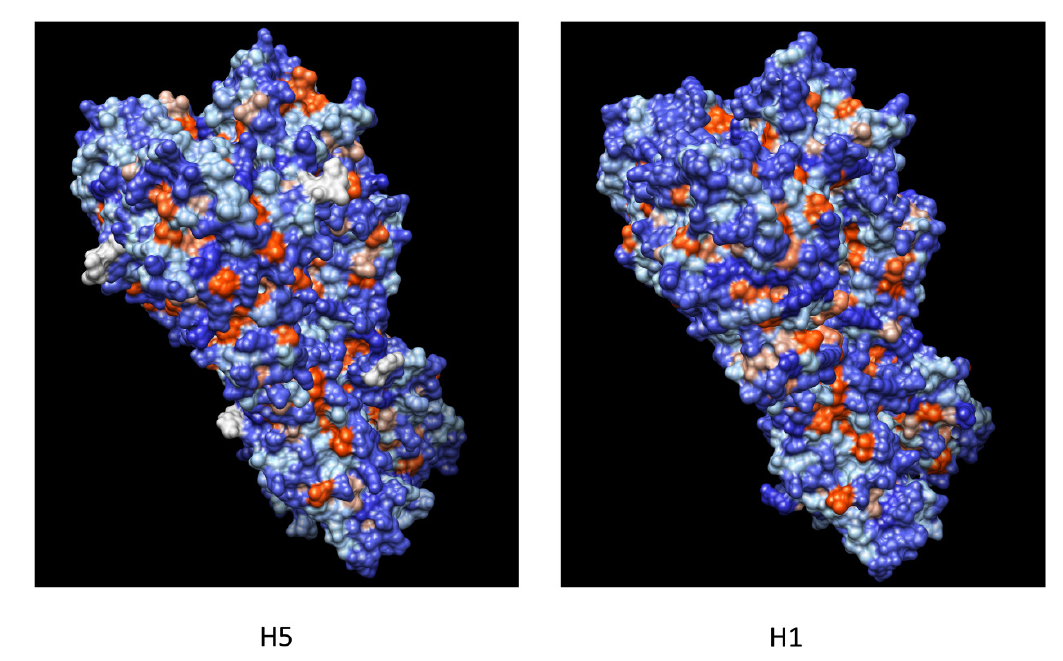
Figure 2. Crystal structures of influenza HAs (H5 and H1). The color transition (red to blue) indicates the different hydrophobic (red) and hydrophilic (blue) regions present on the HAs. Analysis performed using the Kyte-Dolittle